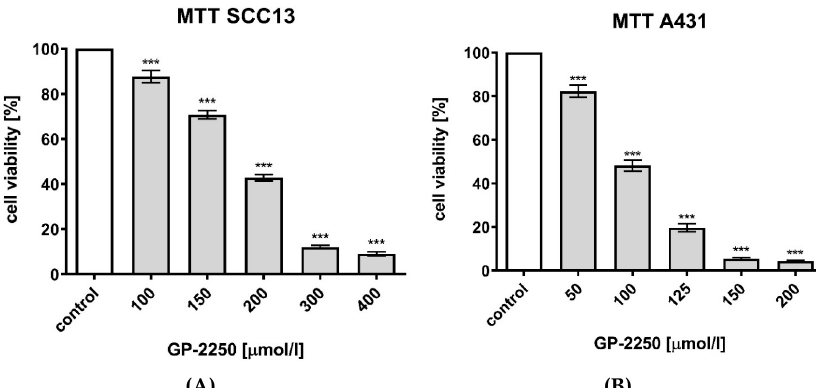
Figure 2. Effects of Substance GP-2250 in different cSCC cell lines, measured by MTT assay. ( A ) SCC13 cells were incubated with GP-2250 (100, 150, 200, 300 and 400 μ mol/L) for 24 h. ( B ) A431 cells were incubated with GP-2250 (50, 100, 125, 150 and 200 μ mol/L) for 24 h. Values are expressed as mean value ± SD of 8 independent experiments. The asterisk symbols indicate significant differences between controls.